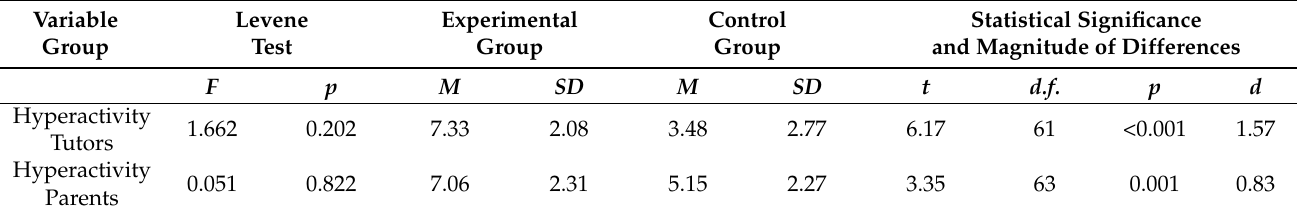
Table 1. Differences in Hyperactivity of the Attention Deficit Hyperactivity Disorder (ADHD) Rating Scale V (RS-V), teachers version and parents version.